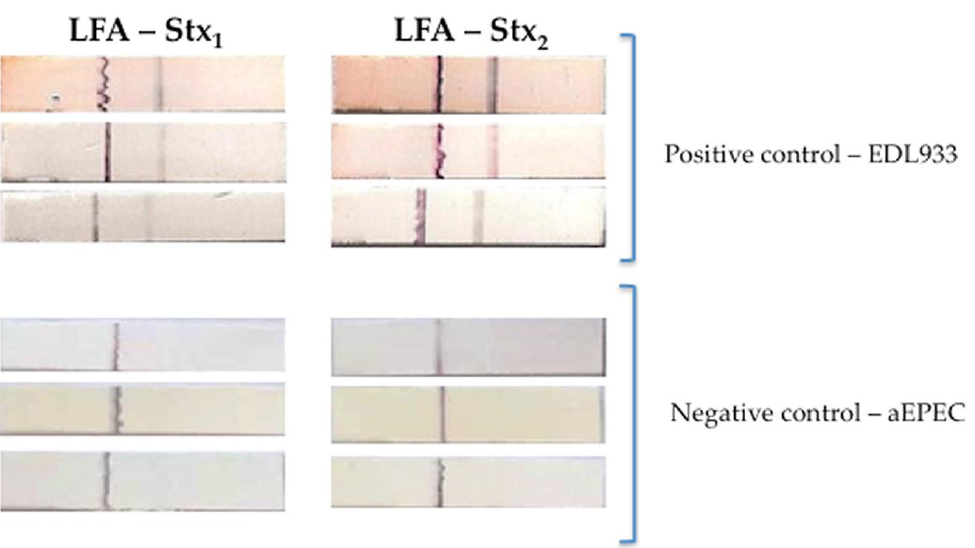
Figure 3. Representative image of positive (EDL933 – O157:H7) and negative (atypical EPEC–aEPEC- O127:H7) controls strains in a lateral flow assay (LFA) employing Stx 1 or Stx 2 antibodies. Triplicates of each experiment. Microorganisms 2019 , 7 , x FOR PEER REVIEW